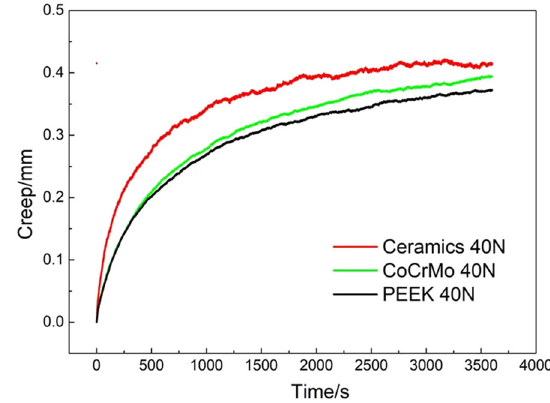
Fig. 5 Creep curves of different contact